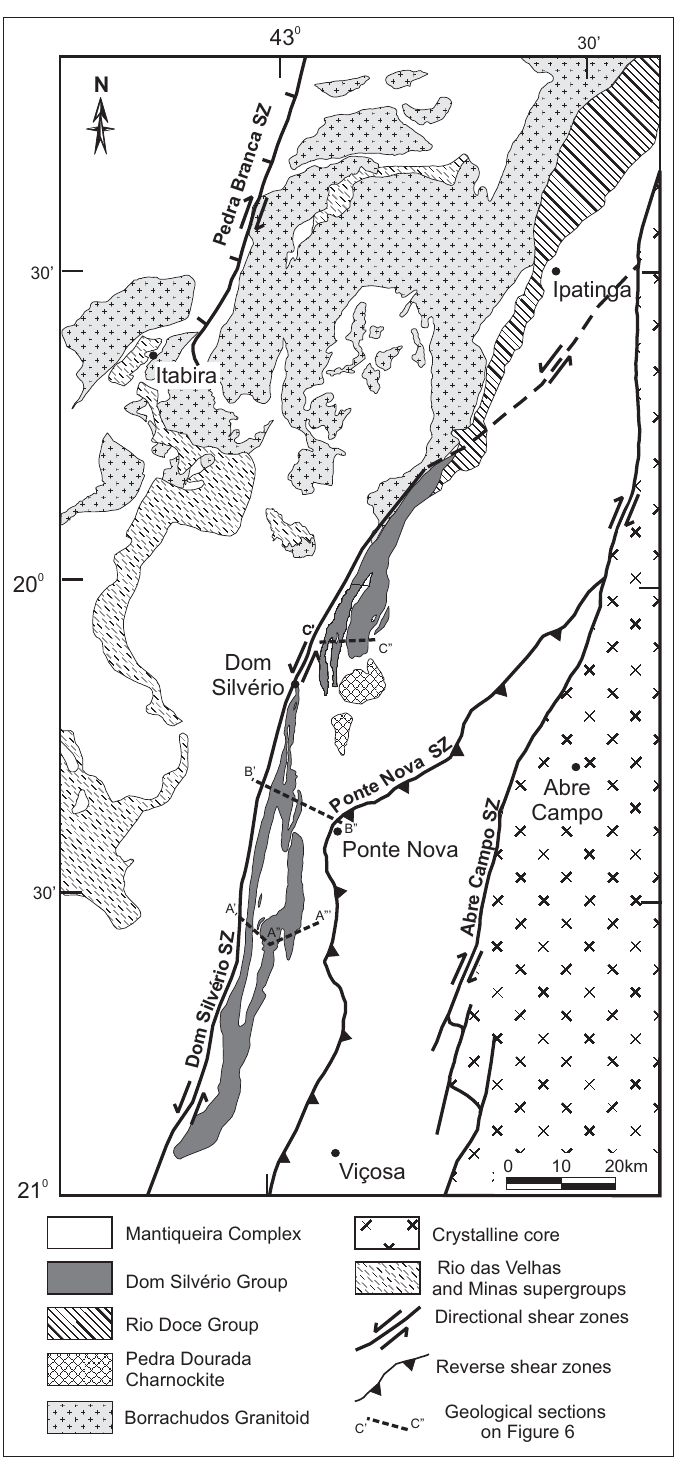
Fig. 4 – Simplified geologic map of the study area showing the distribution of main lithologic